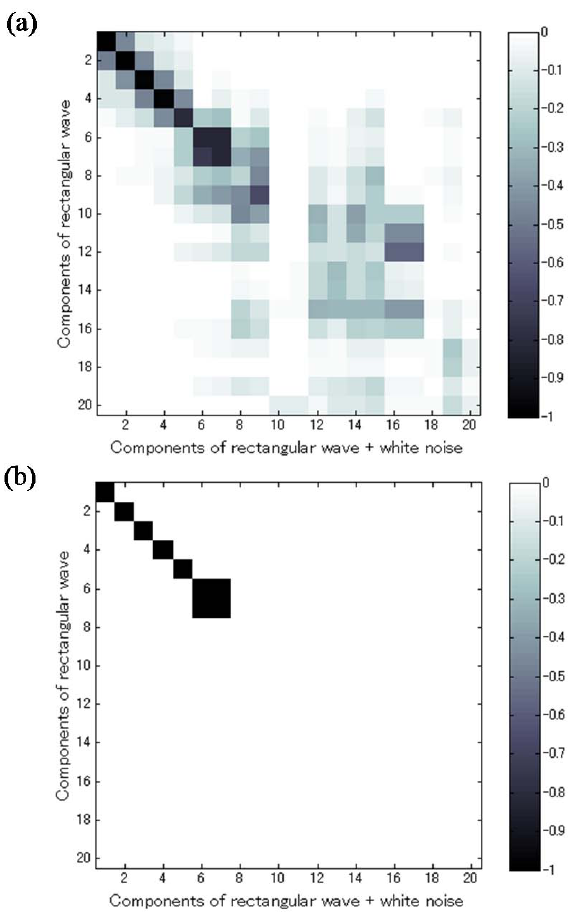
Fig. 8. The correlation diagram. The horizontal and the vertical axes correspond to the number of the principal component of the simulated data and the model data, respectively. (a) The correla- tion diagram between Fig. 6a and c. The brightness shows the cor- relation. (b) The correlation diagram with the correlation r > 0 . 7